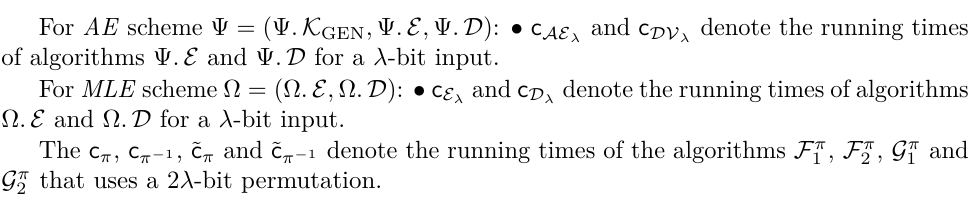
Table 1: Comparison table for generic KAS-AE schemes (Subsection 4.2) built from generic KAS schemes (Subsubsection 2.3.3) using AE . Here, the assumption is that for all the KAS-AE schemes, the underlying KAS and AE are computationally